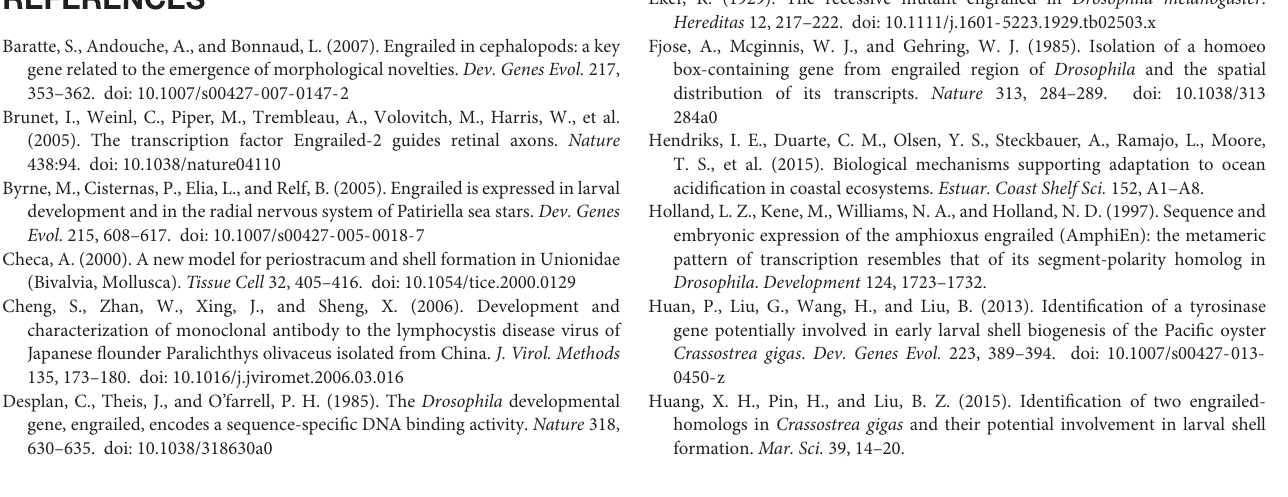
Supplementary Figure 1 | The structure of the edge of oyster mantle. The outer fold was close to the edge of the shell and the inner fold was close to the gill tissue. The black arrow indicated the expression of Cg engrailed-1 protein. MF, middle fold of mantle edge; OF, outer fold of mantle edge; PG, periostracal